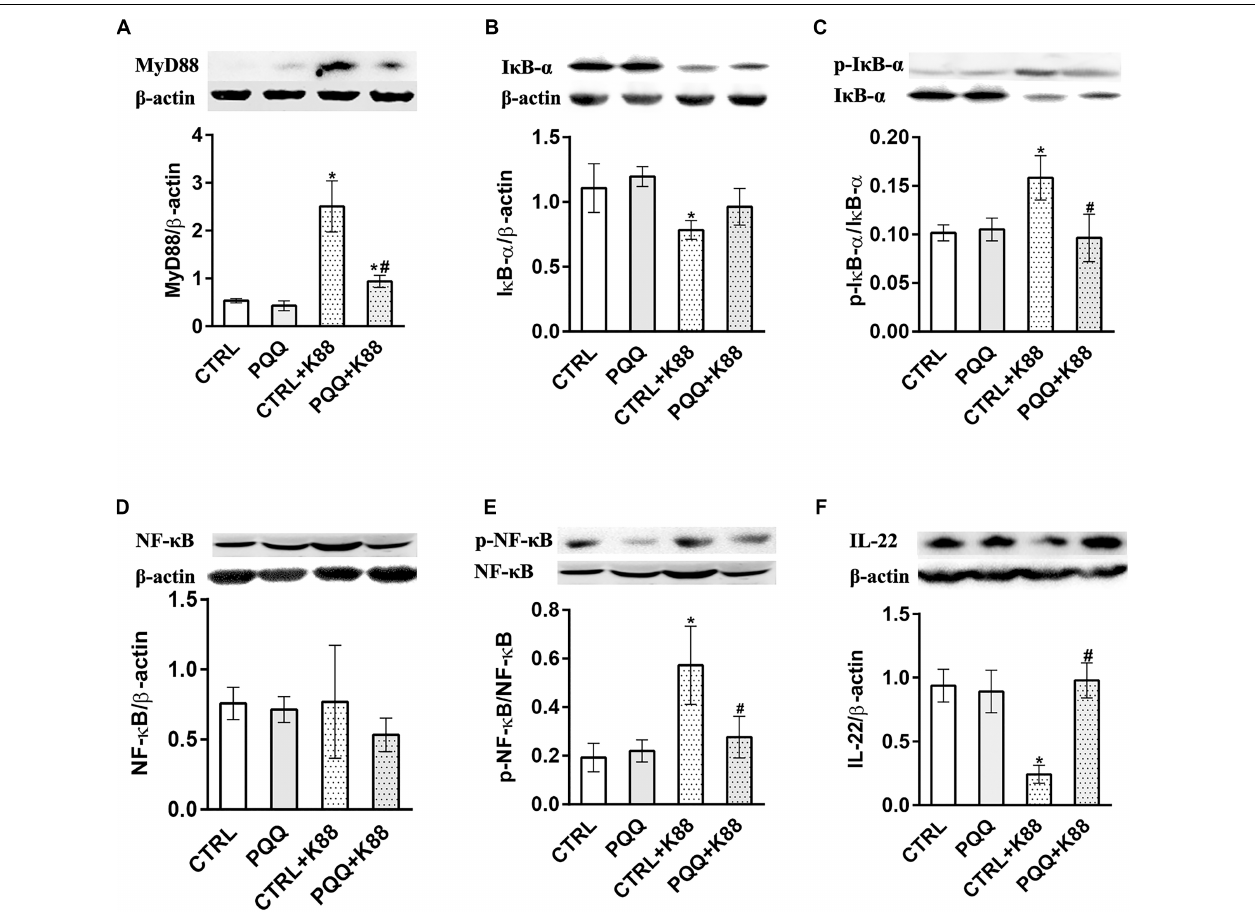
FIGURE 3 | Effects of PQQ supplementation on the expression of proteins within the NF- κ B signaling pathway in the jejunum after ETEC K88 challenge in weaned piglets. (A–F) Expression levels of MyD88, I κ B- α , p-I κ B- α , NF- κ B, p-NF- κ B, and IL-22 proteins are shown. CTRL, piglets fed the basal diet; PQQ, piglets fed the basal diet supplemented with PQQ; CTRL + K88, piglets fed the basal diet and challenged with ETEC K88; PQQ + K88, piglets fed the basal diet supplemented with PQQ and challenged with ETEC K88. * denotes a significant difference ( P < 0.05) from the CTRL group. # denotes a significant difference ( P < 0.05) from the CTRL + K88 group; n =